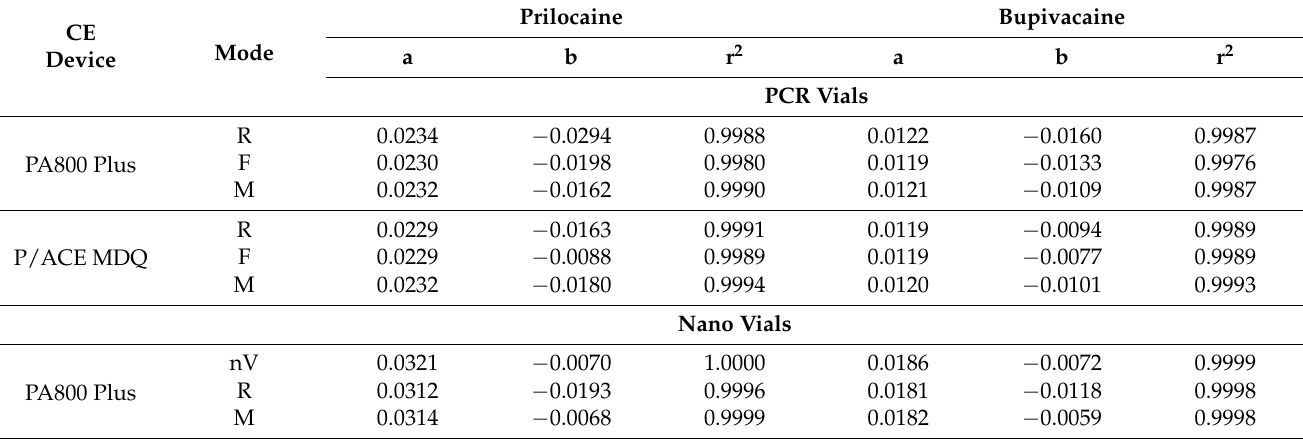
Table 2. Calibration parameters obtained for prilocaine and bupivacaine using PCR vials and SCIEX ® nanoVials. CE Device